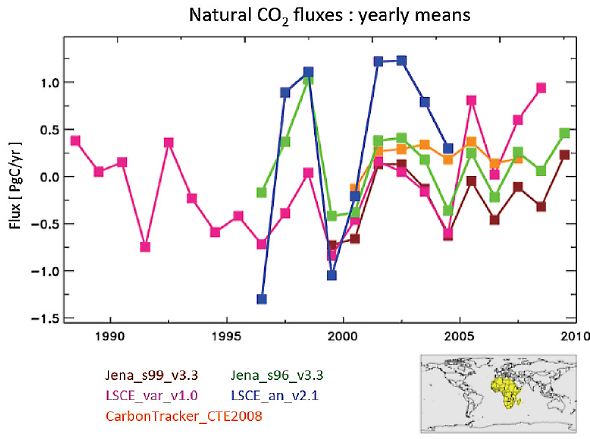
Fig. 2. Year to year variations in the net CO 2 flux of Africa seen by five recent inversions. The CO 2 flux includes land-use CO 2 emis- sions and other ecosystem CO 2 fluxes, and fossil CO 2 emissions as well